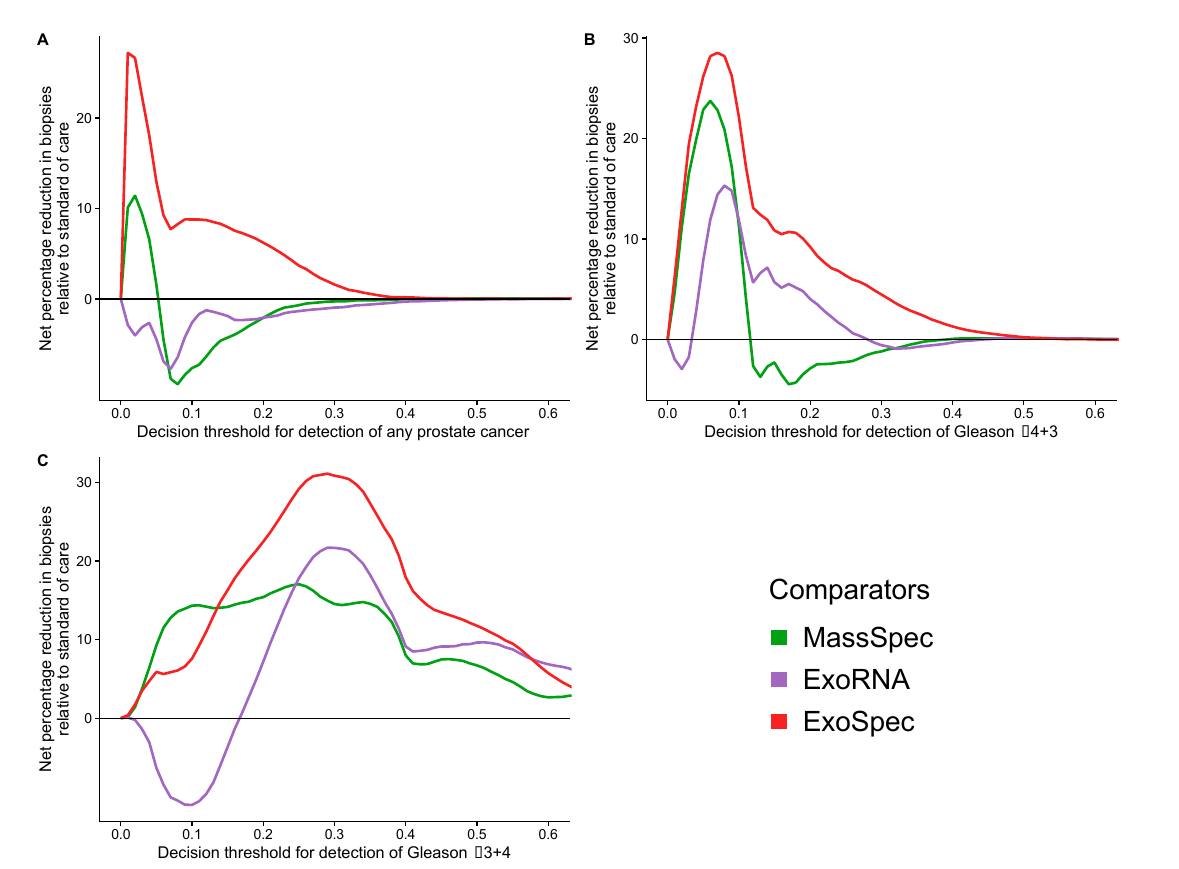
Figure 5. Potential reductions in unnecessary biopsies for each proposed model. Estimated from the net benefit of each model when compared to standard of care. Accepted risk thresholds for the interpreter before agreeing to biopsy are shown on the x -axis. Each panel details the estimated percentage reduction in biopsies for a differing biopsy outcome: ( A ) detection of any prostate cancer, regardless of Gleason; ( B ) detection of Gleason ≥ 3 + 4; ( C ) detection of Gleason ≥ 4 + 3. Green lines—biopsy patients based on the results of the MassSpec model, purple—the ExoRNA model, red—the ExoSpec model. The mean change in biopsies performed were calculated across 1000 stratified bootstrap resamples and presented here as a percentage.